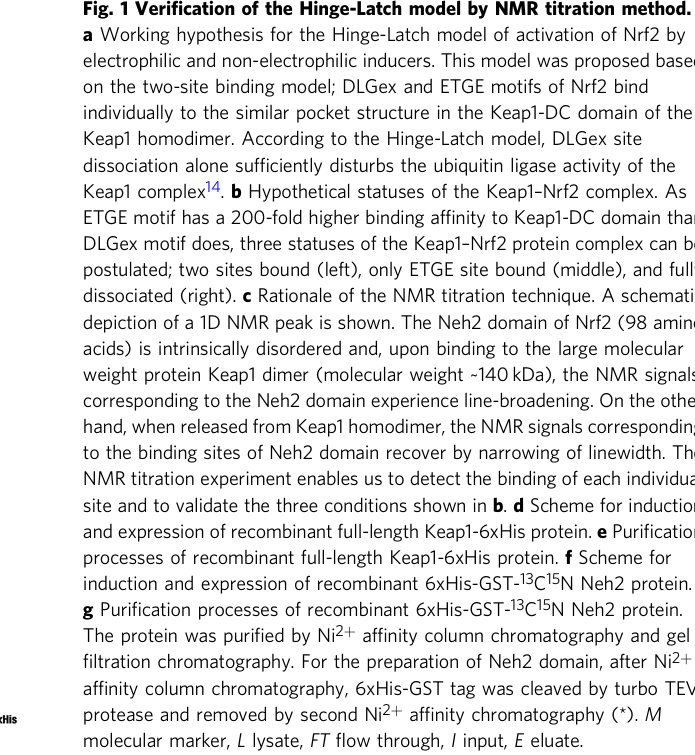
Fig. 1 Veri fi cation of the Hinge-Latch model by NMR titration method. a Working hypothesis for the Hinge-Latch model of activation of Nrf2 by electrophilic and non-electrophilic inducers. This model was proposed based on the two-site binding model; DLGex and ETGE motifs of Nrf2 bind individually to the similar pocket structure in the Keap1-DC domain of